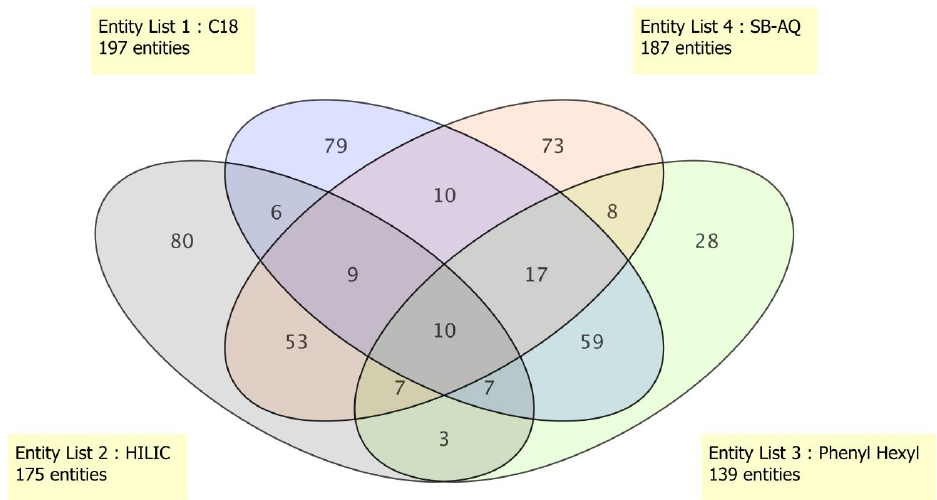
Figure 5. METLIN library matched compound distribution based on column chemistry. Figure drawn using MPP Software.